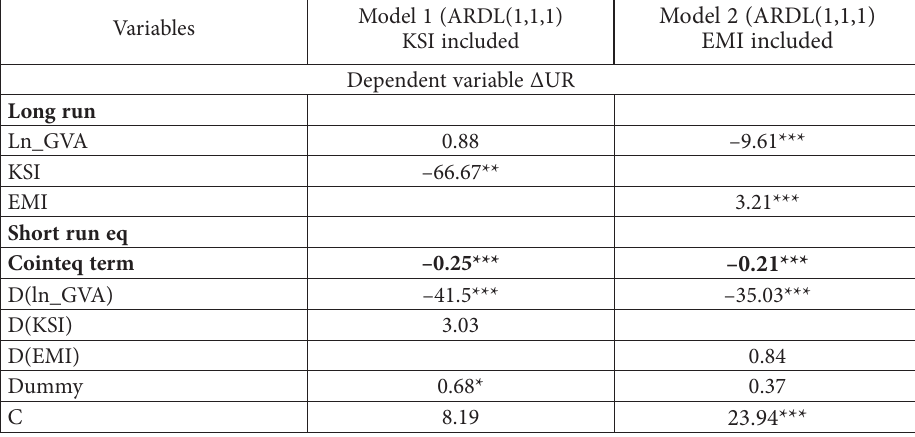
Table 7. Panel unit root results for Trade, transportation, accommodation and food, and business and administrative services (TRADE)